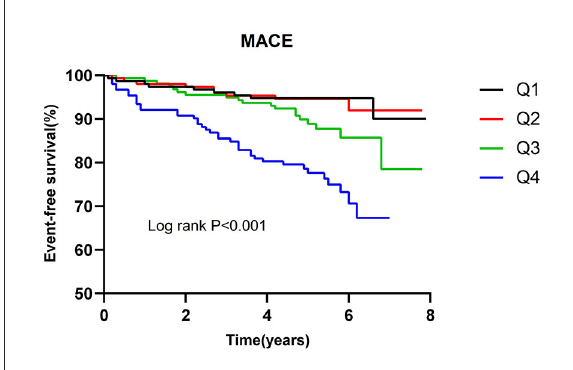
FIGURE3 Kaplan-Meier survival curve for MACE across multimarker scores